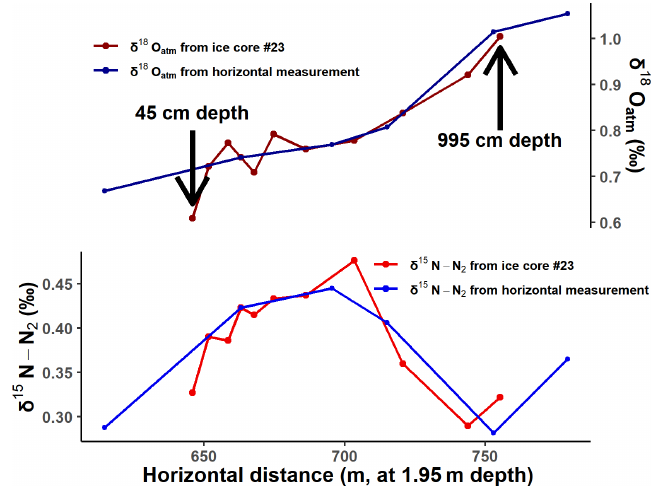
Figure A2. Nitrogen and oxygen gas isotope record of ice core no. 23 and horizontal measurement. Horizontal measurement is conducted using ice cores at 1.95m depth. Depth of ice core no. 23 was converted to horizontal distance at 1.95m depth by using Eq. (3). The uncertainty in a measured δ 18 O atm at a depth of 1.95m is assumed to be ± 0.05‰ (see Sect.